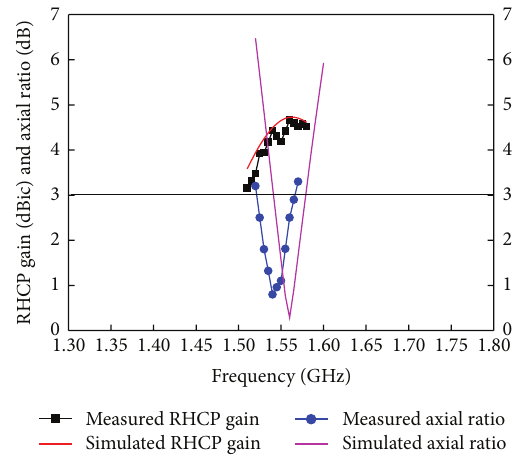
Figure 8: Measured and simulated RHCP gain and axial ratio of the fabricated antenna.